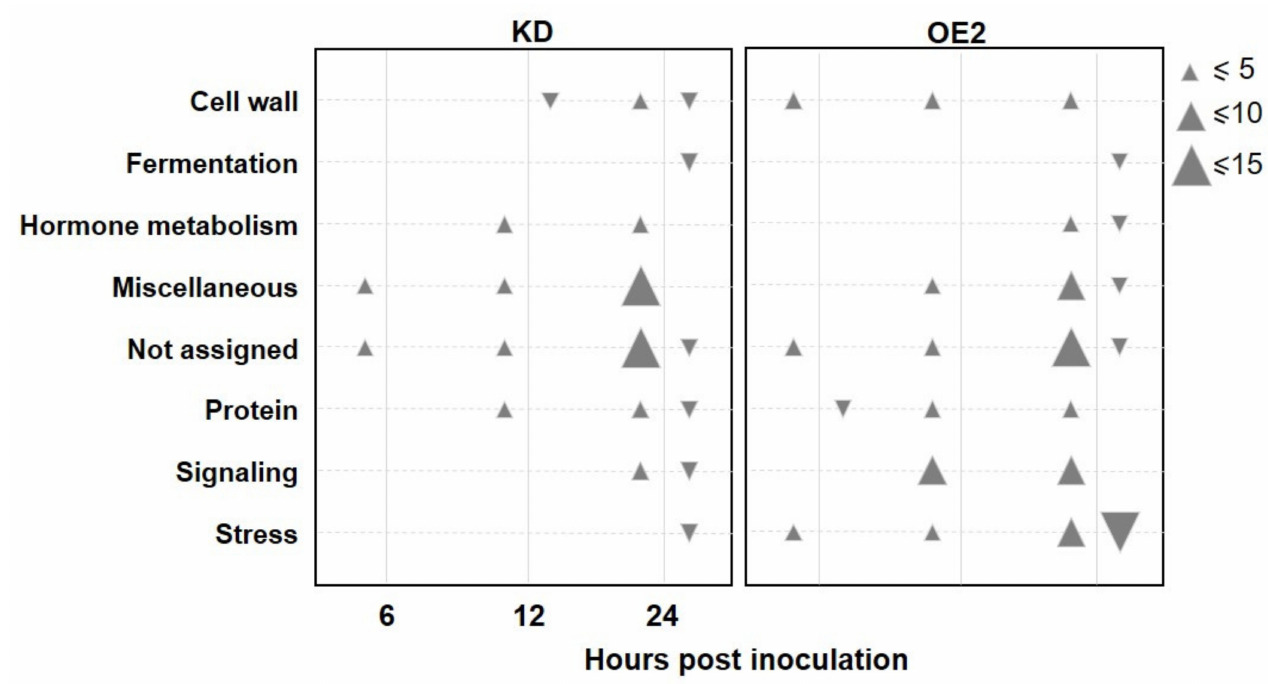
Figure 5. Functional categories significantly over-represented for CML8-dependent DEGs (Table S1) following Rs infection in CML8 KD and OE2 lines, obtained with MapMan Classification Super Viewer. The down- and up arrows correspond to down-regulated DEGs and up-regulated DEGs, respectively. The size of triangle indicates the number of DEGs in each